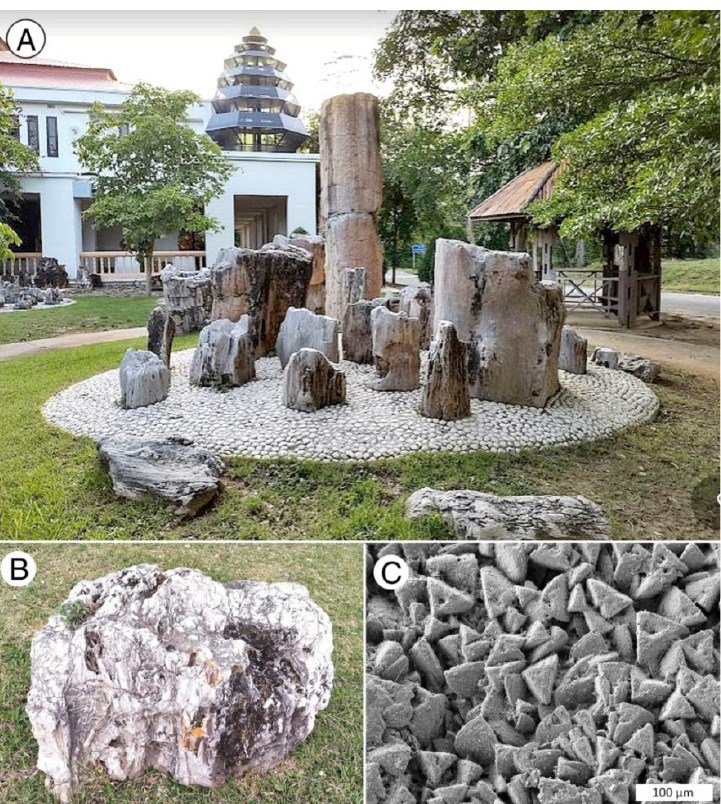
Figure 29. Outdoor displays of fossil wood at Khorat Petrified Wood Museum. ( A ) Garden plaza exhibit. ( B ) Log S-11 showing white surface crusts caused by evaporation of water used for irrigating adjacent lawn. ( C ) SEM image of calcium carbonate crust on log